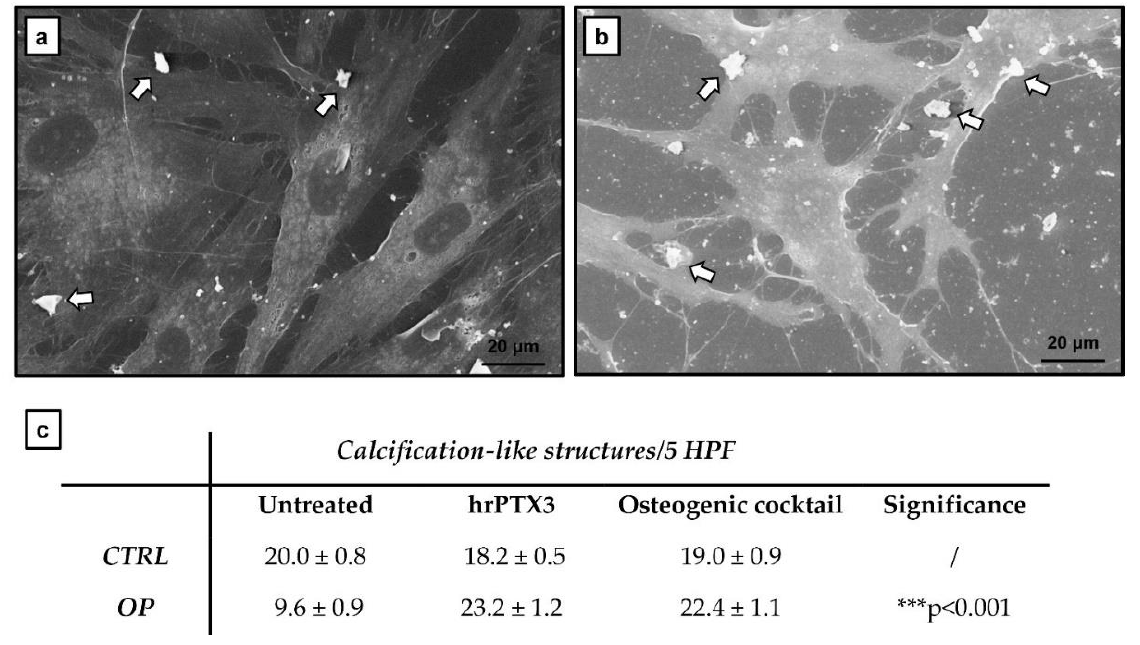
Figure 5. Scanning electron microscopy (SEM) – energy-dispersive X-ray spectroscopy (EDX) microanalysis on human osteoblast primary cultures. ( a , b ) Representative image of CTRL and OP cultures treated with hrPTX3 and osteogenic cocktail; calcification-like structures (arrow) can be seen. Scale bar 20 μm . ( c ) Evaluation of calcification-like structures amount.